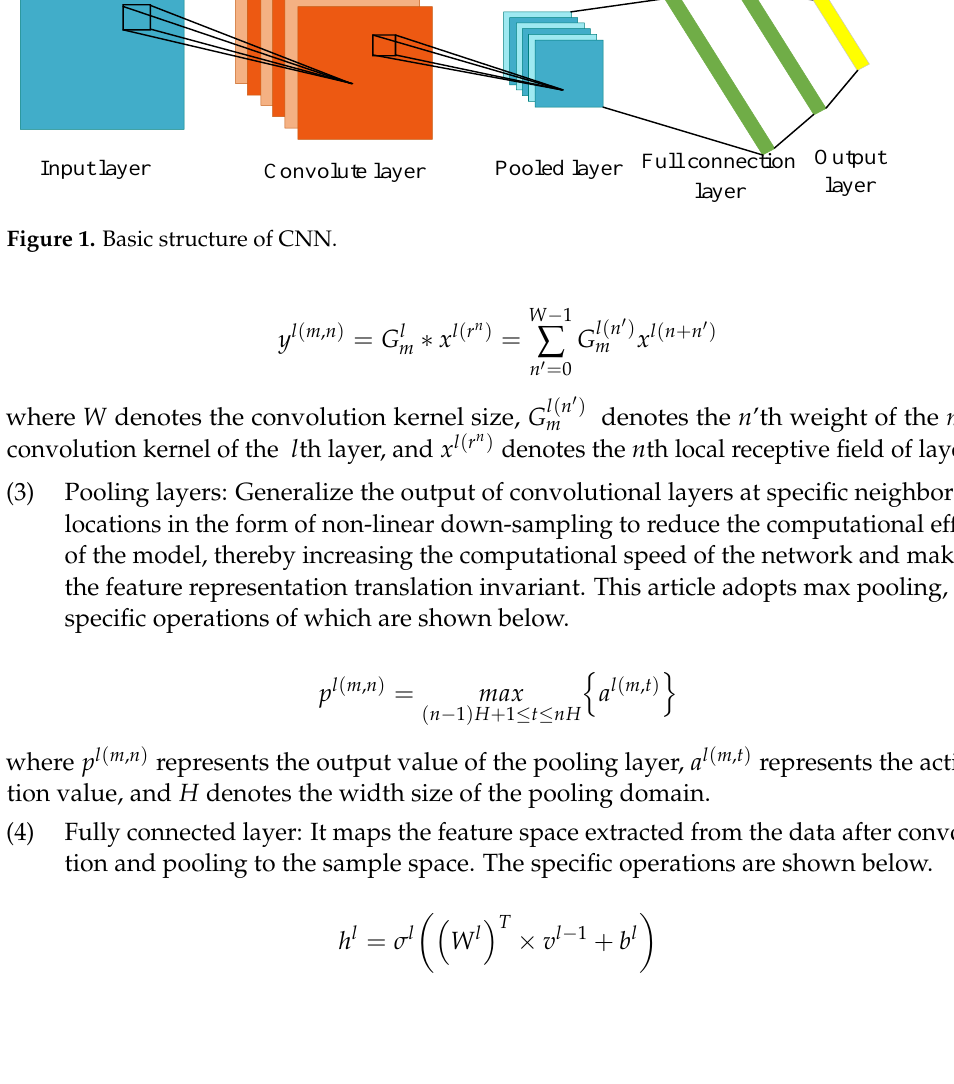
Figure 2. Comparison of ordinary convolution kernel and dilated convolution kernel. ( a ) Conven- tional 1 × 3 convolution kerel; ( b ) dilated convolution 1 × 3, dilation rate is 2.